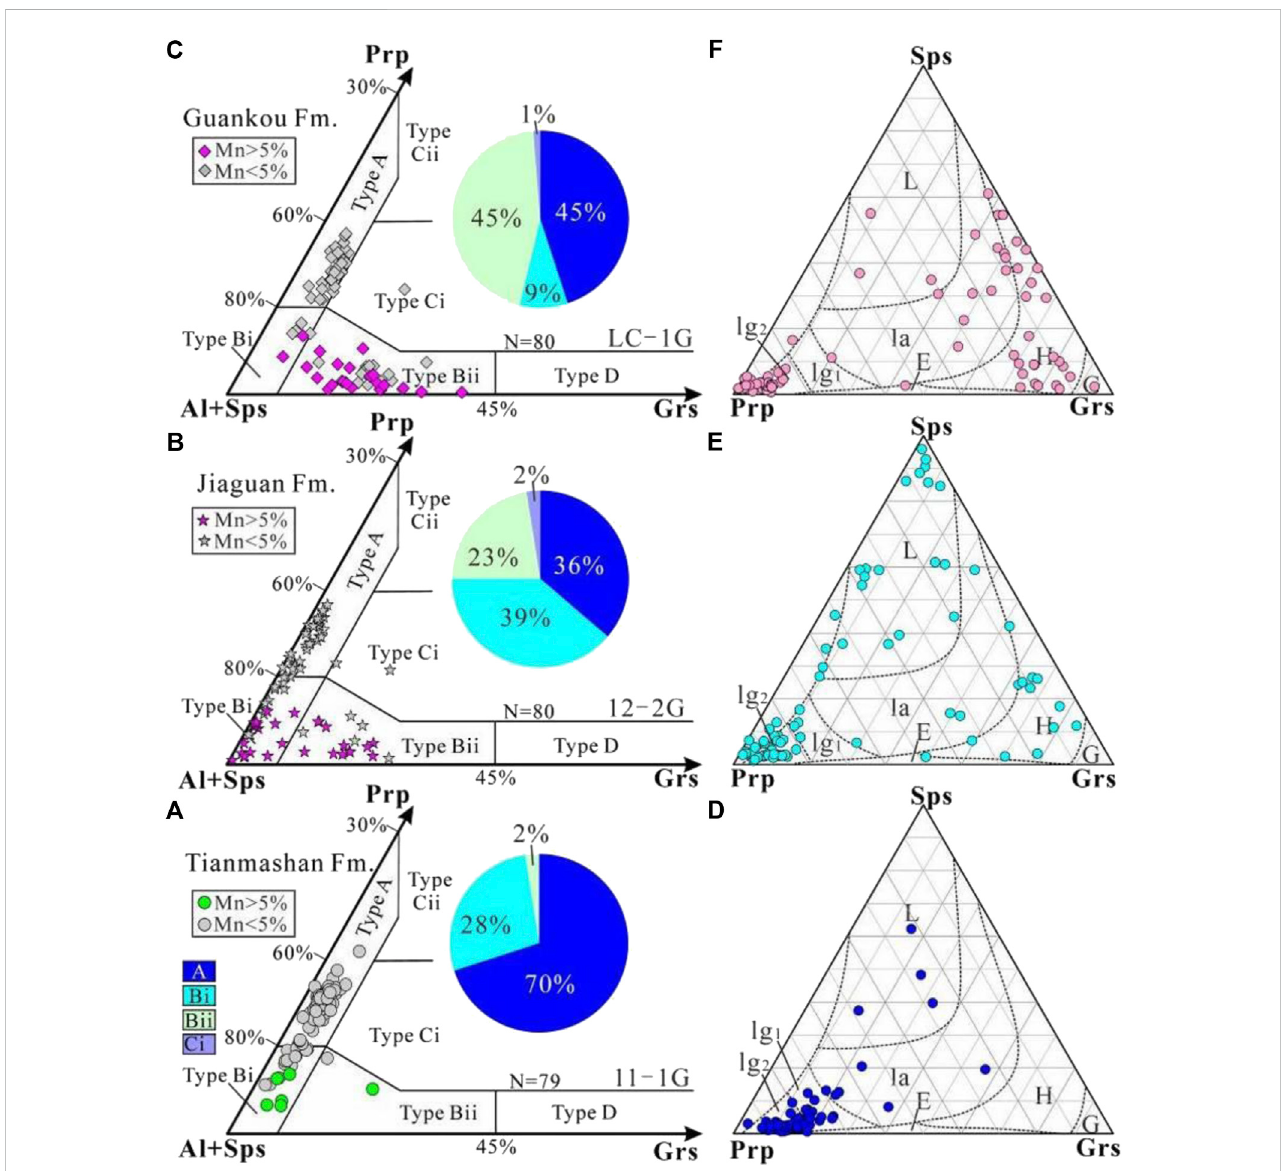
Sps), pyrope (Prp) and grossular (Grs) compositions as poles. Prp = pyrope, Alm = almandine, Sps = spessartine, Grs = grossular. A-sourced from granulite facies metasediments, charnockites, or intermediate to acidic deeper crust rocks; Bi-from intermediate to acidic igneous rocks; Bii-from